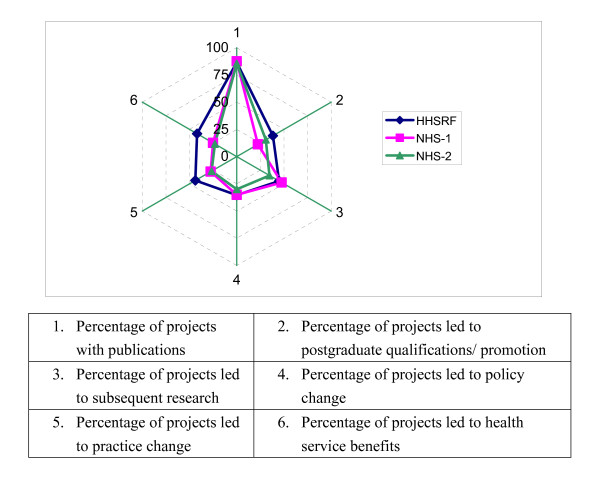
Comparison of the Health and Health   Services Research Fund (HHSRF) and two National Health Service Research and   Development Programmes (NHS-1 [12] and NHS-2 [13]) in various payback   categories.